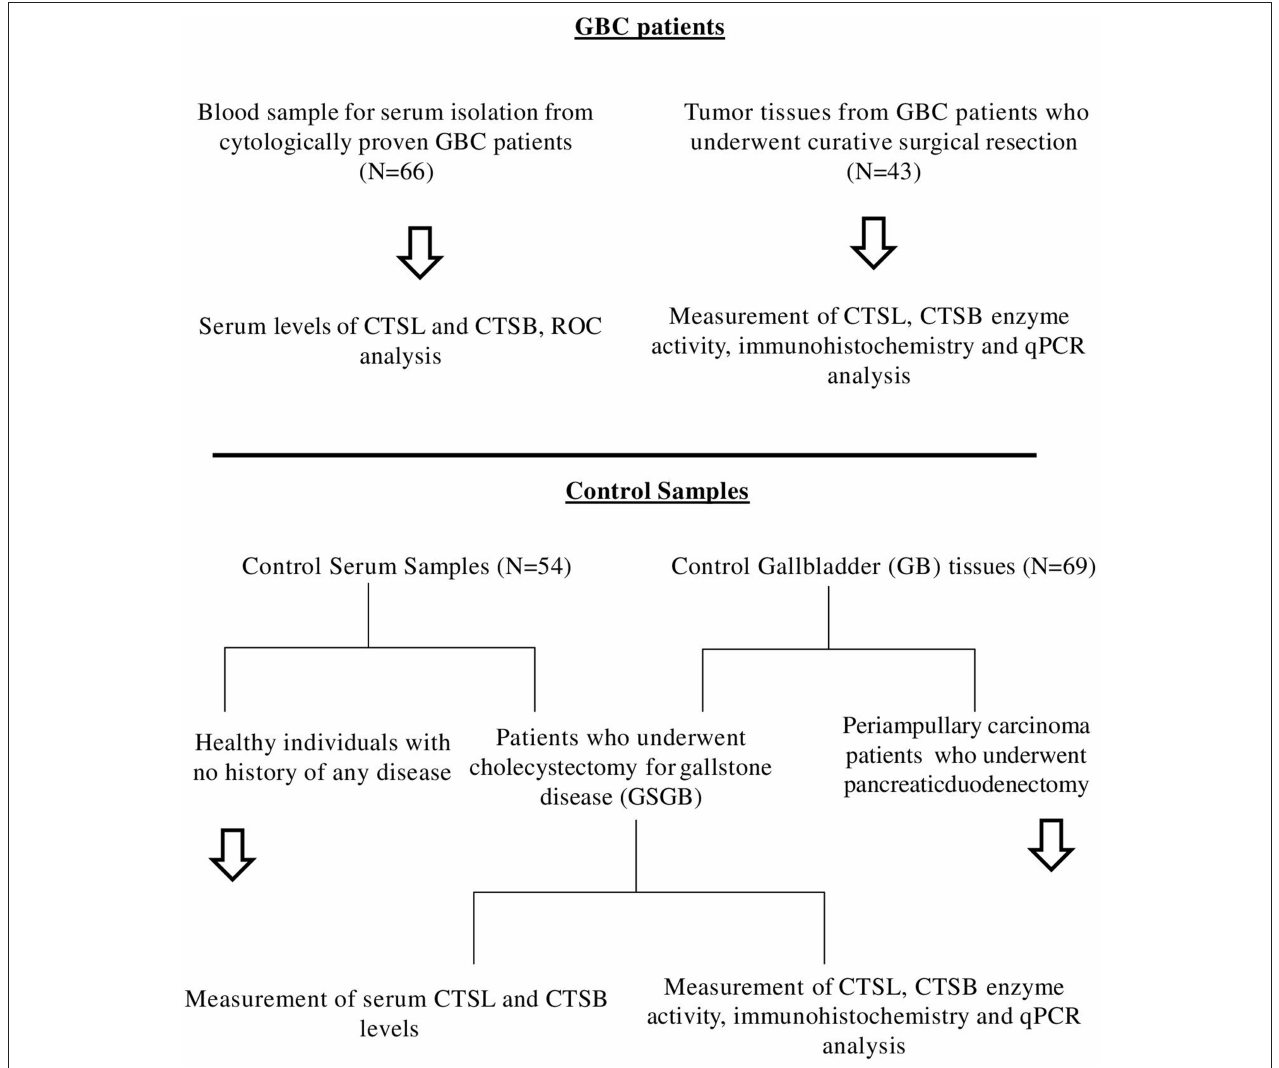
FIGURE 1 | Schematic representation of sample collection and work flow for GBC patients and controls used in this study.